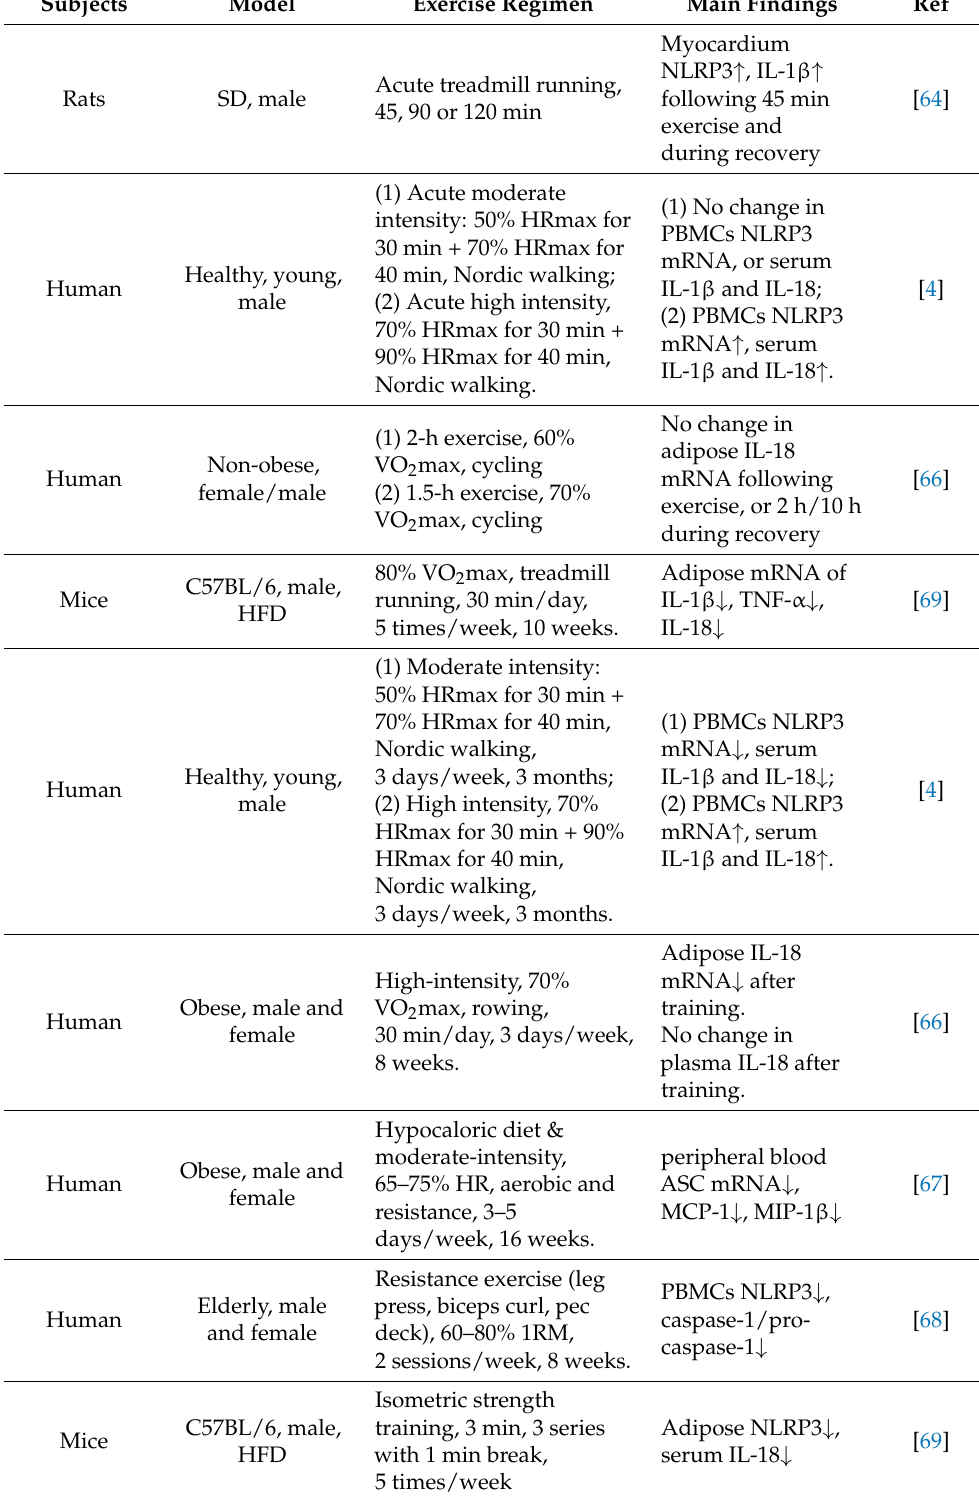
Table 1. The effects of different types of exercise intervention on NLRP3 inflammasome